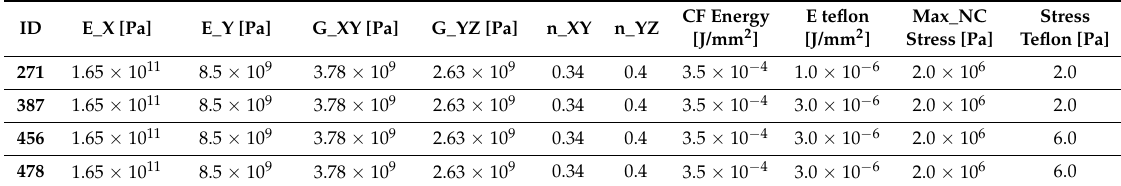
Table 2. Numerical delamination energies.